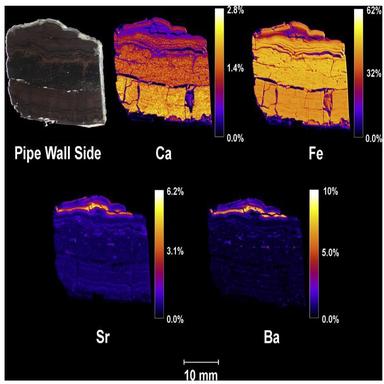
Micro-XRF mapping of sample 5.